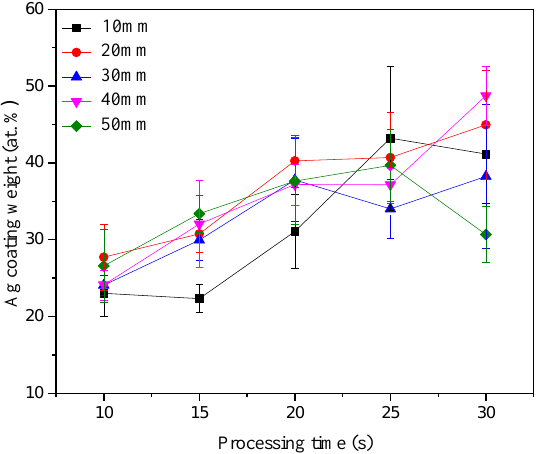
Figure 11. Comparison of measured mean values and standard deviations of silver coating weight for different electrode distances and processing times, when KNO 3 concentration of 5 wt.% and AgNO 3 concentration of 0.03 wt.% are fixed.